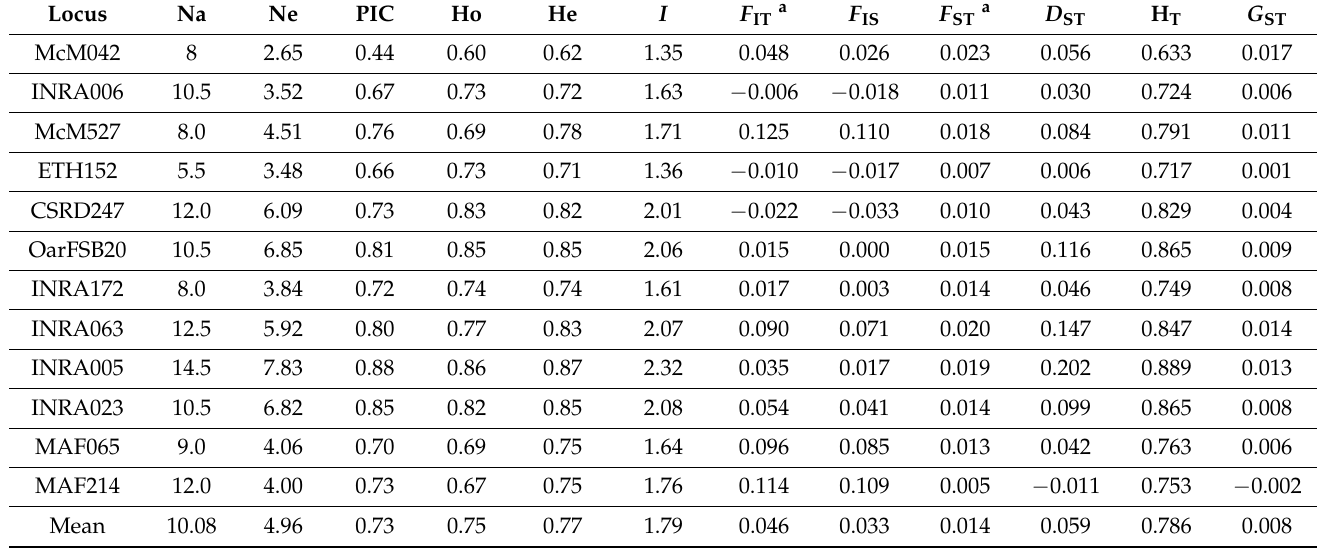
Table 2. Number of identified alleles per locus (Na), number of effective alleles (Ne), polymorphism information content (PIC), heterozygosities observed (Ho) and expected (He), Shannon’s information index ( I ), F IT (inbreeding coefficient), F IS (inbreeding coefficient of an individual relative), F ST (fixation index), D ST (gene diversity between populations), H T (total expected heterozygosity), and G ST (genetic diversity among populations) in each